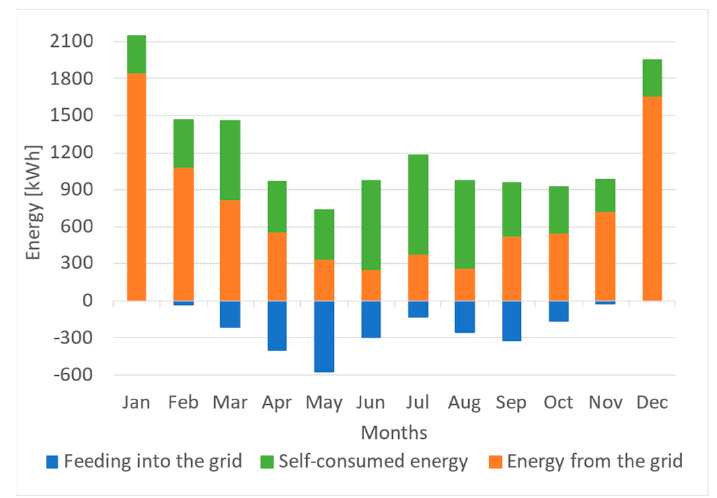
Figure 12. Monthly energy consumption 2021 − Plant (6 kWp) in northern Italy.